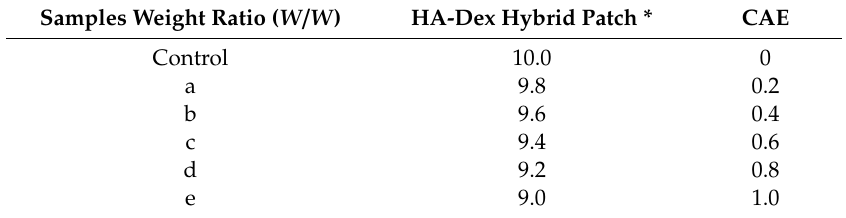
Table 1. Processing conditions for fabrication of CAE embedded HA-Dex hybrid patches. Samples Weight Ratio ( W / W ) HA-Dex Hybrid Patch *